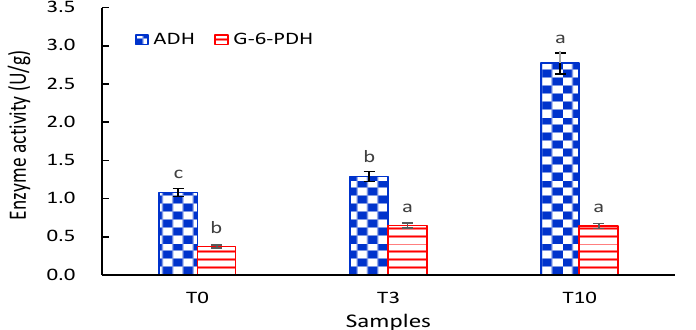
Figure 4. Effects of D. officinale on the activities of alcohol dehydrogenase (ADH) and glucose-6- phosphate dehydrogenase (G6PDH) in S. cerevisiae . Different letters indicate significant differences between different samples at p <